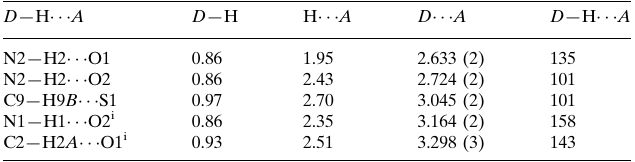
Hydrogen-bond geometry (A˚ , (cid:2)